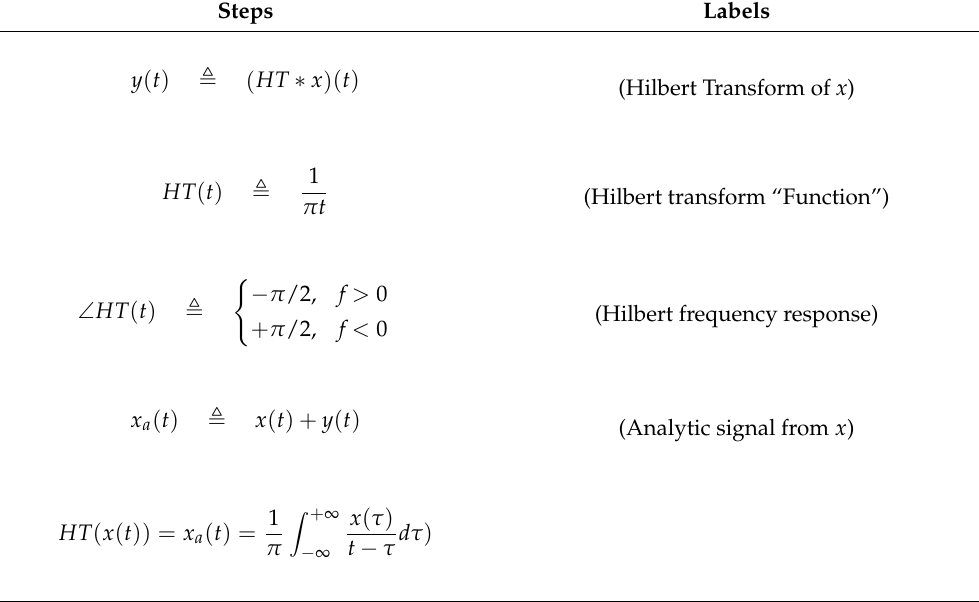
Table 1. Summary of the Hilbert transform